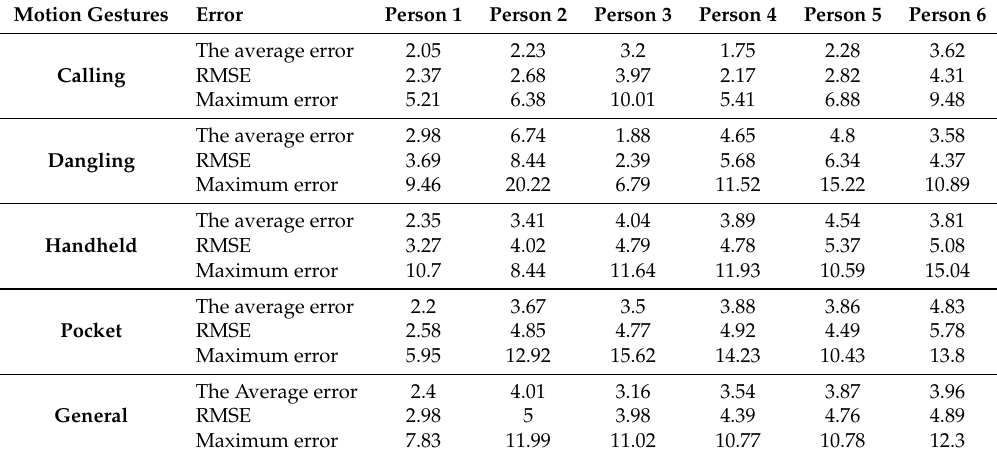
Table 3. Position errors with different persons